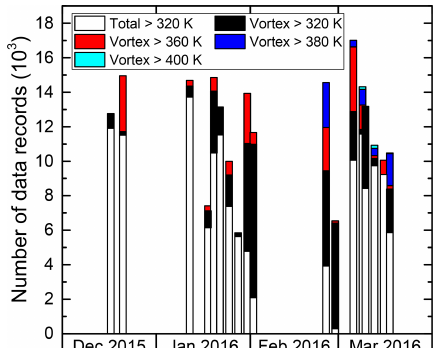
Figure 5. Vortex air sampling statistics of the PGS campaign, counted by the number of individual HCl measurements. Each col- umn represents a single science flight. Coloured bars indicate por- tions above selected